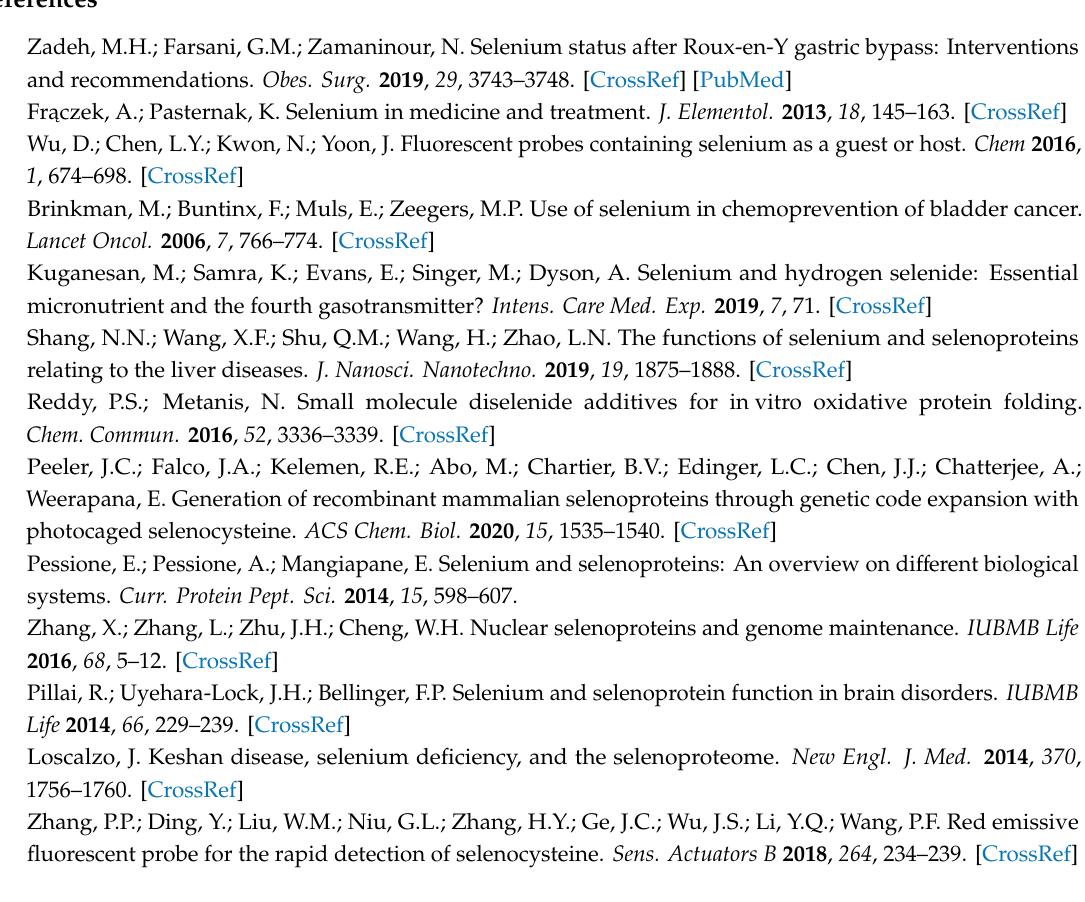
reported Sec fluorescent sensors and detection method, Figure S1: 1 H NMR spectrum of compound Q5 (DMSO- d 6 ), Figure S2 13 C NMR spectrum of compound Q5 (DMSO- d 6 ), Figure S3 HRMS spectrum of compound Q5 , Figure S4 1 H NMR spectrum of compound Q6 (DMSO- d 13 C NMR spectrum of compound Q6 (DMSO- d 6 ), Figure S5 6 ), Figure S6 HRMS spectrum of compound Q6 , Figure S7 1 H NMR spectrum of compound Q7 (DMSO- d 6 ), Figure S8 13 C NMR spectrum of compound Q7 (DMSO- d 1 H NMR 6 ), Figure S9 HRMS spectrum of compound Q7 , Figure S10 spectrum of compound P5 (DMSO- d 6 ), Figure S11 13 C NMR spectrum of compound P5 (DMSO- d 6 ), Figure S12 HRMS spectrum of compound P5 , Figure S13 HPLC spectrum of compound Q6 (black), Q7 (pink) and treating Q7 with Sec (blue). Mobile phase: MeOH: H 2 O = 7:3, UV detection wavelength: 420nm, Figure S14 Fluorescent intensity ratios I 550 / I 482 responses of 1 µ M Q7 at 614 nm to Sec (40 µ M) in the presence of various biological analytes (1 mM) in PBS (10 mM, pH 7.40, containing 1% DMSO as cosolvent). Legend: (1) Blank; (2) Hcy; (3)